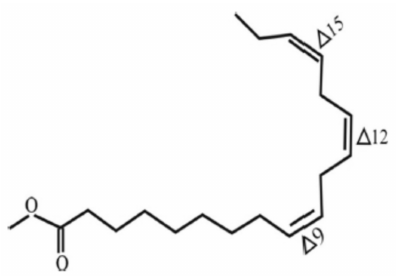
Figure 2. Structure of methyl